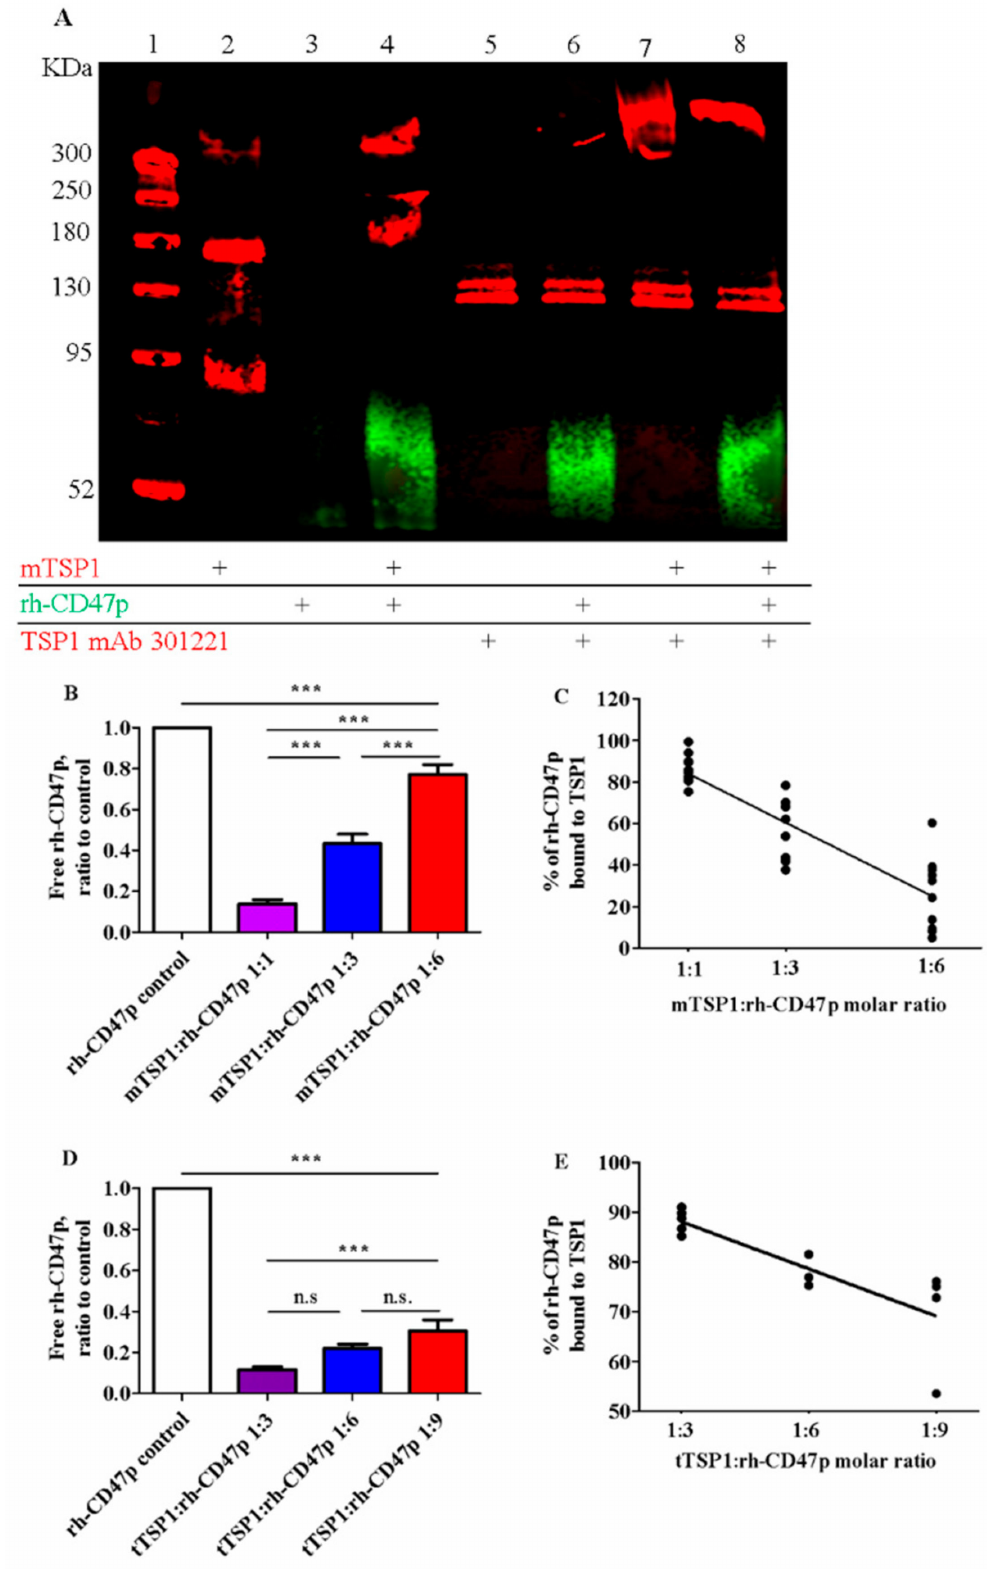
Figure 2. Qualitative and quantitative confirmation of association between TSP1 and the recombinant human CD47 peptide (rh-CD47p). ( A ) Representative image of immunoblots of combination of monomer TSP1 (mTSP1) and rh-CD47p incubated at 37 ◦ C for 60 min in a cell-free setting. Lane 1: molecular weight marker; 2: mTSP1 control; 3: rh-CD47p control; 4: mTSP1+rh-CD47p mixture; 5: TSP1 blocking antibody alone (TSP1 mAb 301221); 6. rh-CD47p+TSP1 blocking antibody;